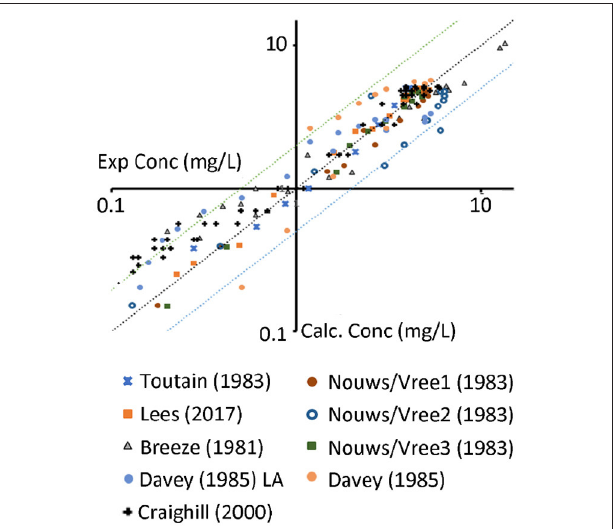
FIGURE 4 | Experimental data (x-axis) vs. predictions (y-axis) of the data from the references above. The middle line represents unity; the lines above/below represent the 2 fold changes. Nouws/Vree 1,2,3 represent different sites of administration (1 neck, 2 shoulder, 3 buttock). Davey represents data from a Long acting (LA) 100 mg/ml product.